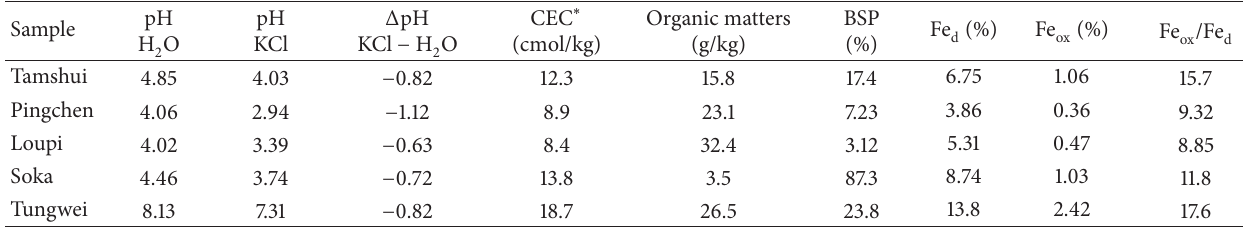
Table 3: Some chemical properties of the lateritic soils being studied.